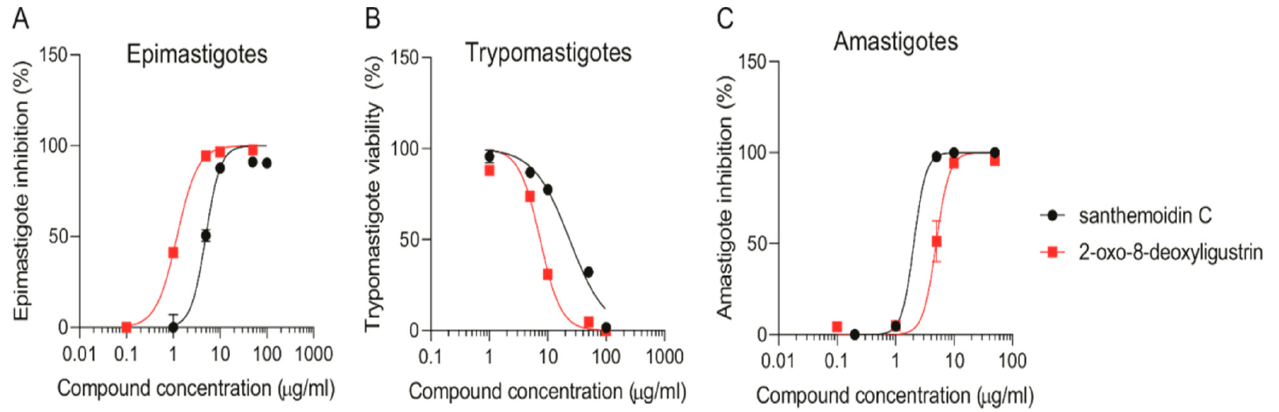
Figure 2. Effect of isolated compounds on the three stages of T. cruzi . Both santhemoidin C and 2-oxo-8-deoxyligustrin were tested at 1–100 µg/mL concentrations in duplicates to evaluate: ( A ): Growth inhibition of T. cruzi epimastigotes. ( B ) Trypanocidal activity against bloodstream trypomastigotes; ( C ) inhibition of T. cruzi amastigotes. Results are expressed as the mean ± SEM.